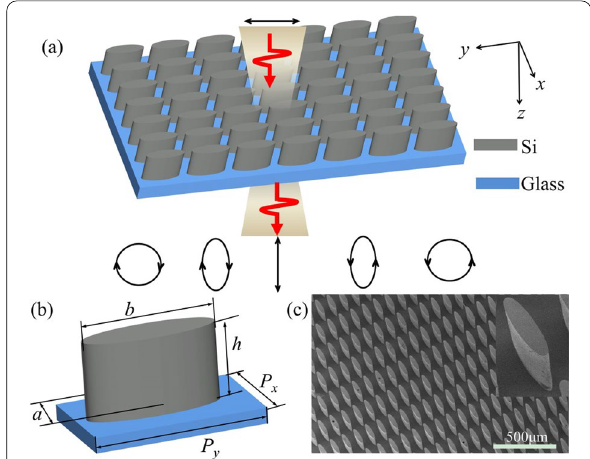
Fig. 1 a Schematic of the dielectric metasurfaces, which realize full polarization control. b Unit cell of the dielectric metasurfaces. c SEM image of typical silicon pillar arrays in a tilted view with a zoom-in